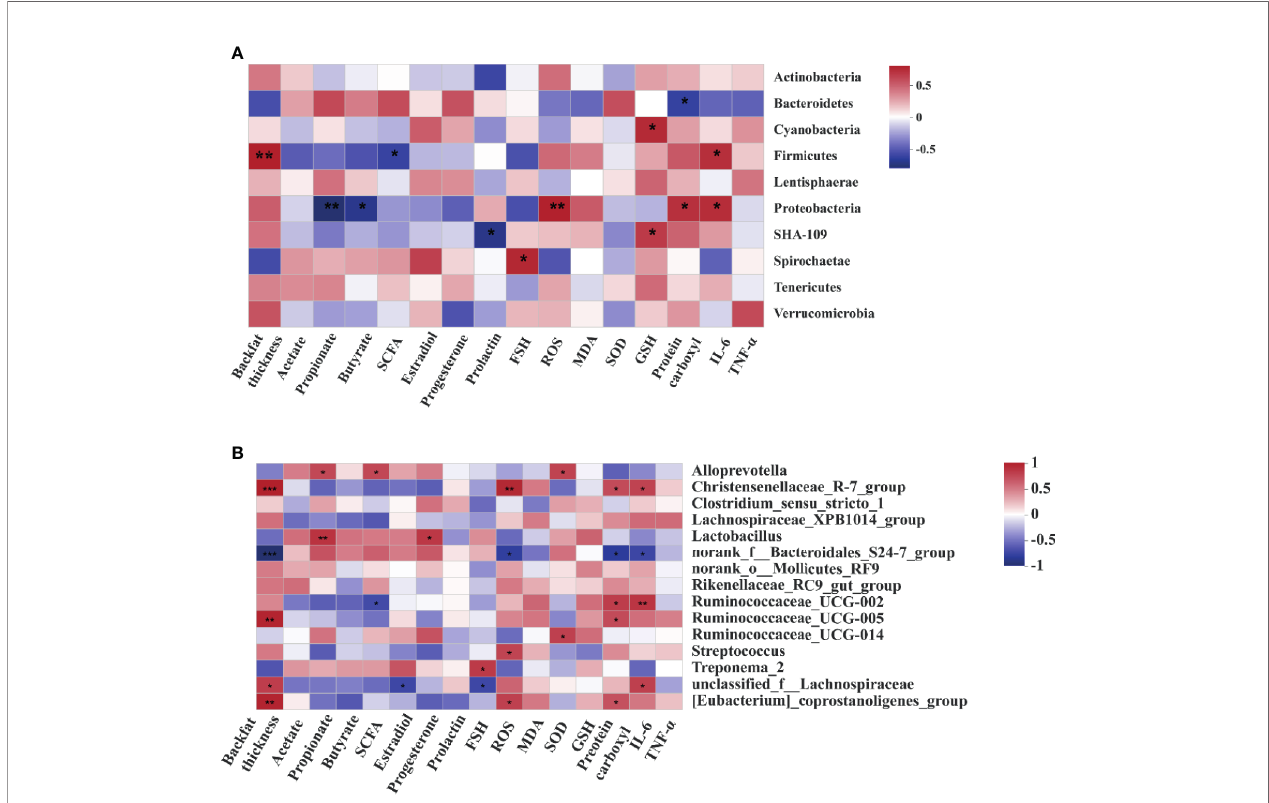
FIGURE 8 | Correlations between the microbiota, backfat thickness, short-chain fatty acids, and hormone levels. Correlation analysis at the phylum (A) and genera (B) levels. “ * ” , “ ** ” , and “ *** ” indicate P < 0.05, < 0.01,and < 0.001